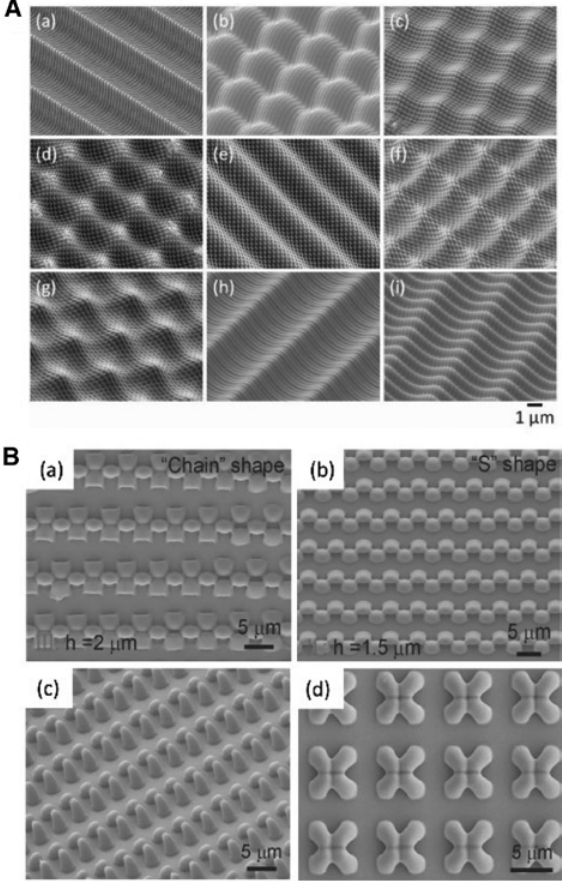
Figure 3: Angle-multiplexed optical imprinting and multibeam laser interference